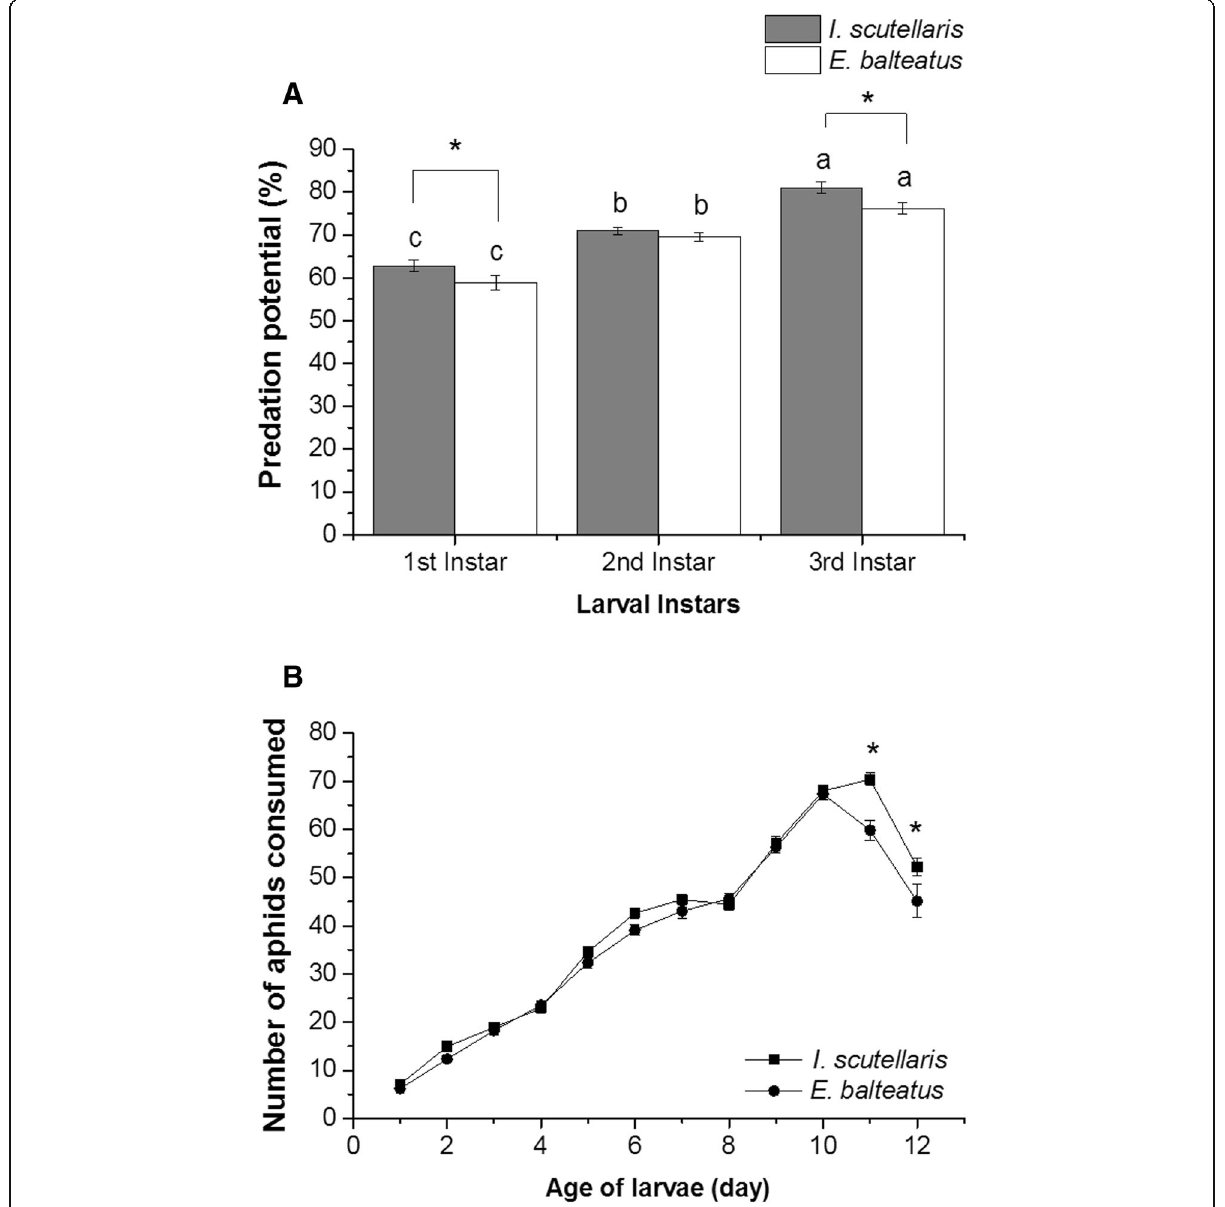
Fig. 4 Prey-consumption rate of I. scutellaris and E. balteatus at different larval instars ( a ) and daily consumption of aphids by syrphid larvae ( b ). The bars are means ± SEM, and the different lowercase letters above each bar demonstrate a significant difference within, while an asterisk above a pair of the bars and data points represents a significant difference between two predator species ( P <